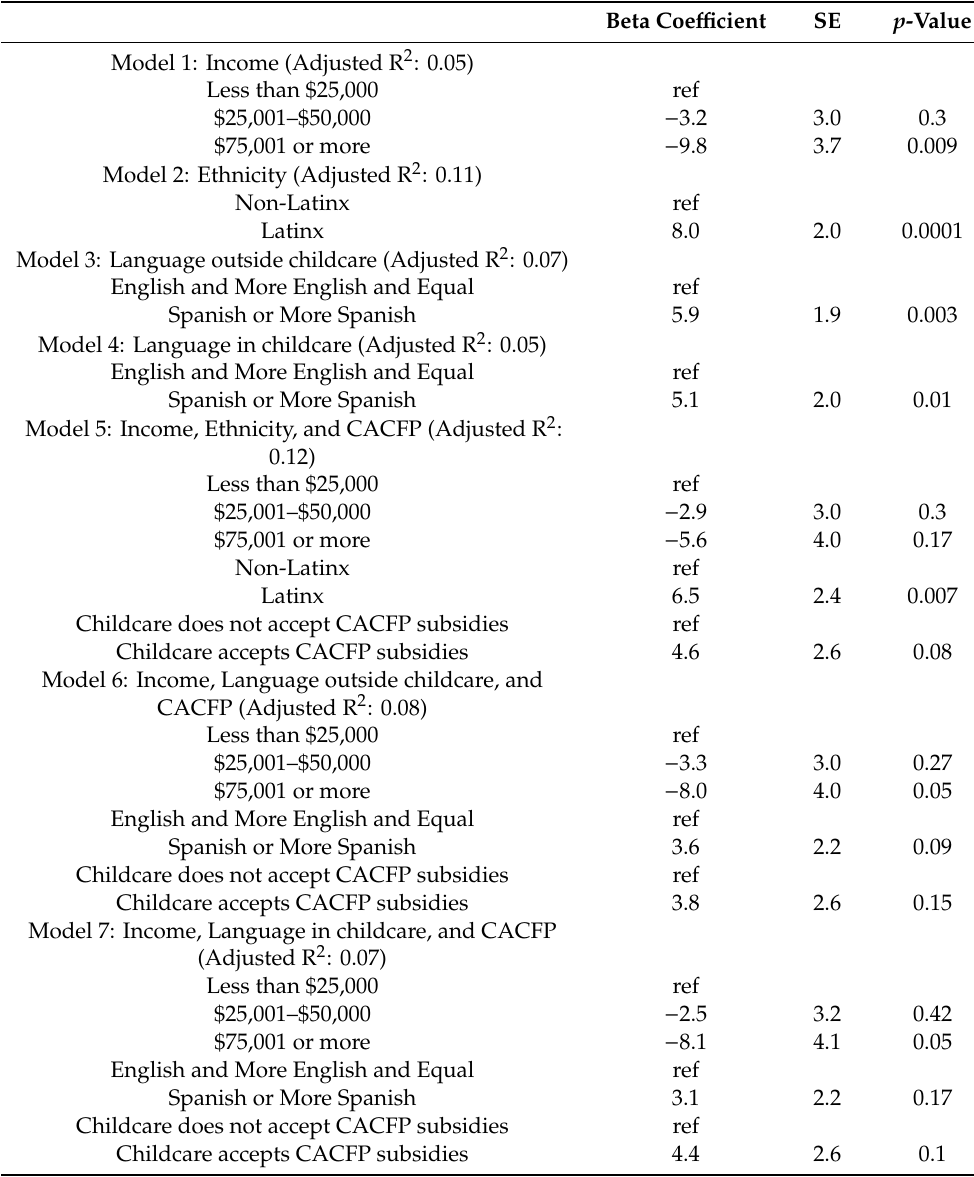
Beta Coe ffi cient SE p